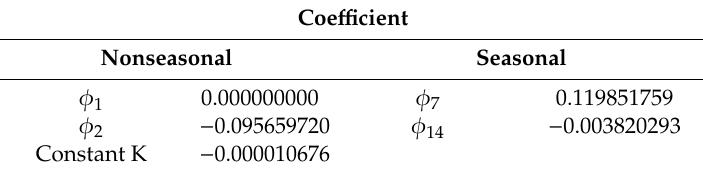
Table 8. SARIMA coe ffi cients. Gas